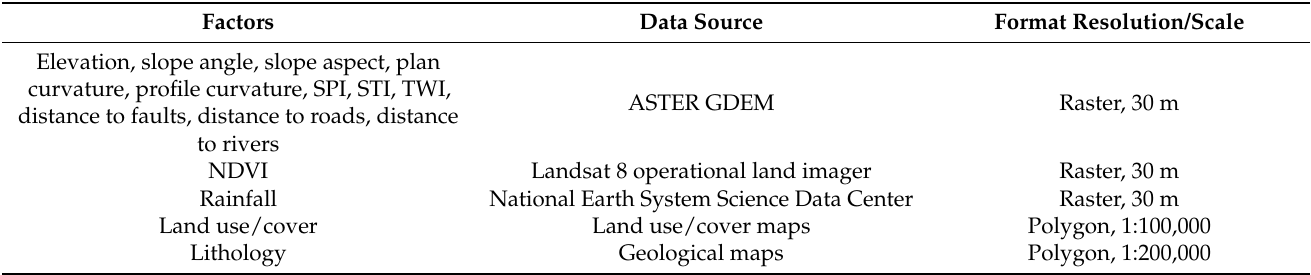
Table 2. Source and scale of conditioning